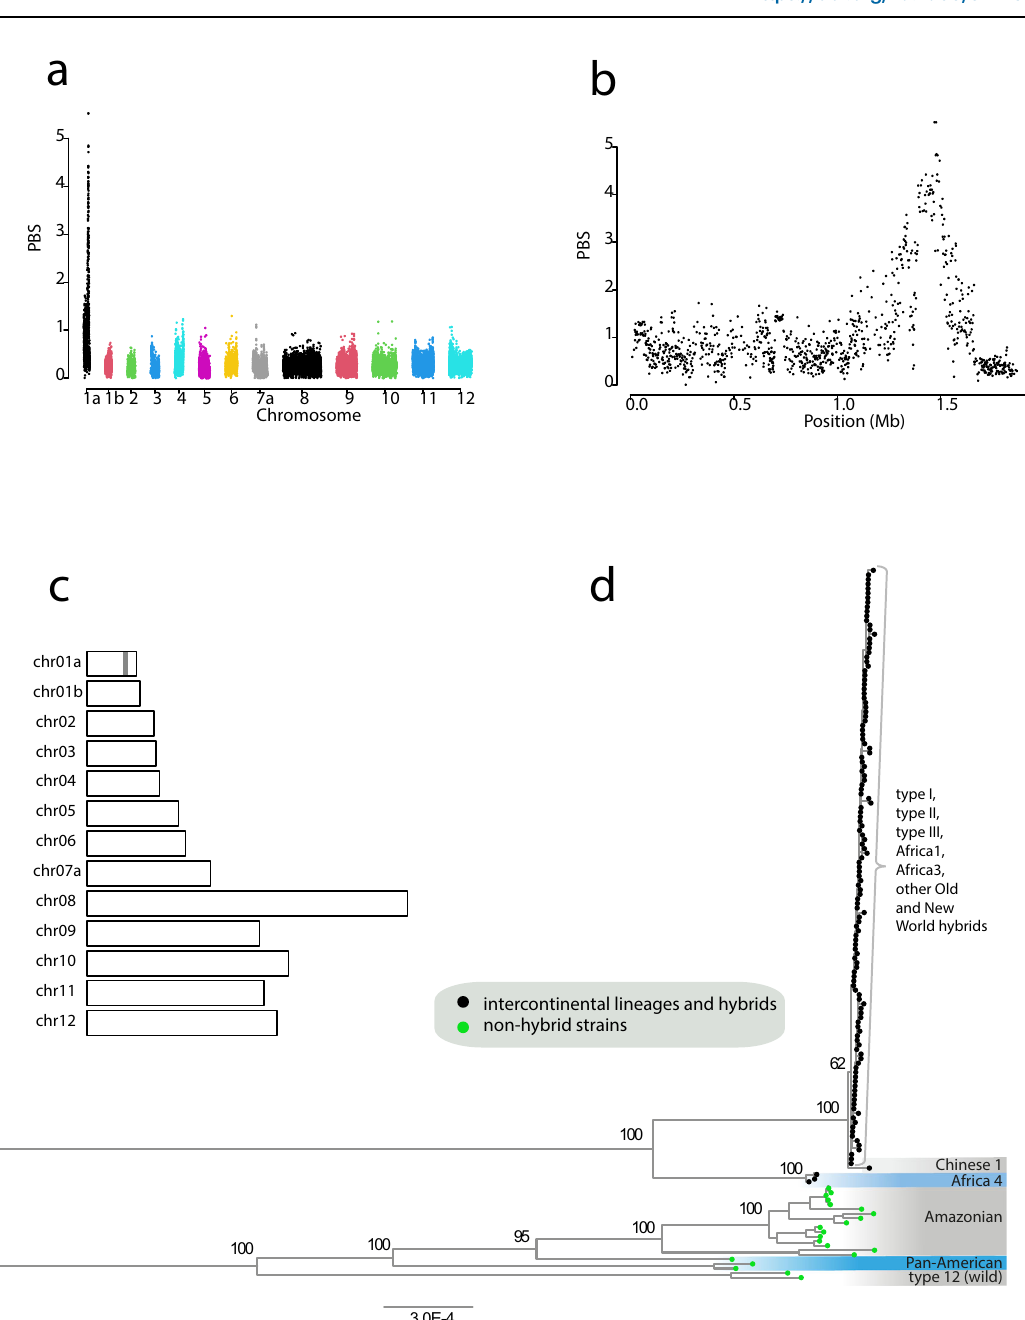
bars. d Phylogenetic tree of the outlier selection region (positions 1,390,579 – 1,502,589 on chromosome 1a). It was produced using iqtree2 under General Time-Reversible (GTR) nucleotide substitution model with a gamma distribution and a proportion of invariant sites (GTR+ Γ + I). Branch support was inferred using 1000 bootstrap replicates. It includes all the strains of the dataset ( n =